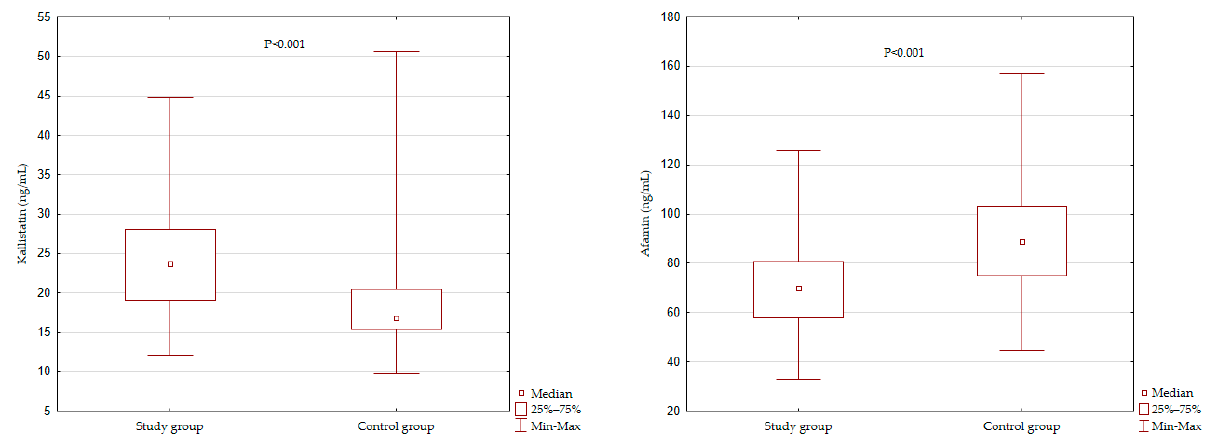
Figure 1. Kallistatin and afamin serum level comparison of studied groups.